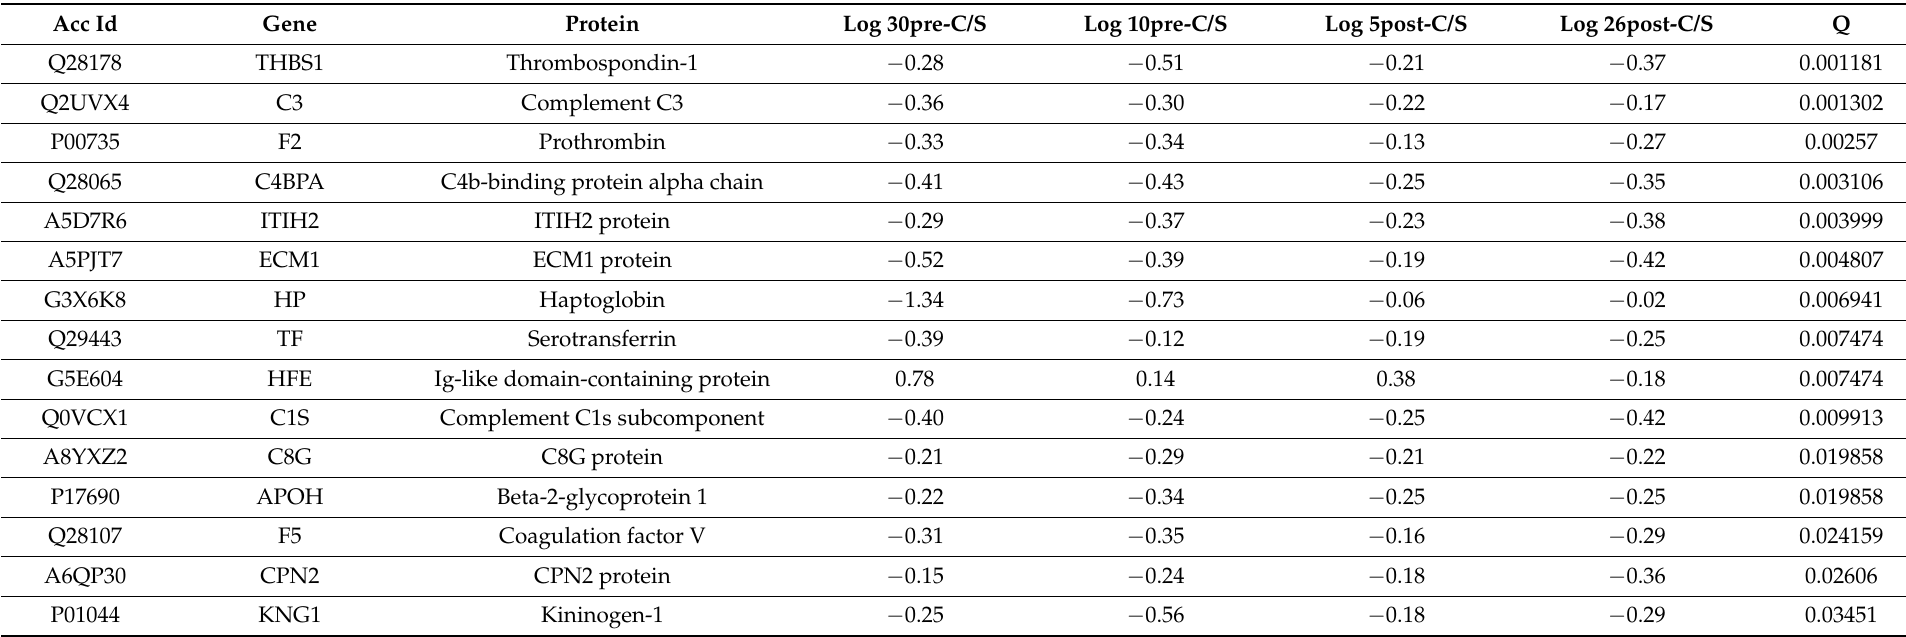
Table 1. List of correlated proteins with significance and fold